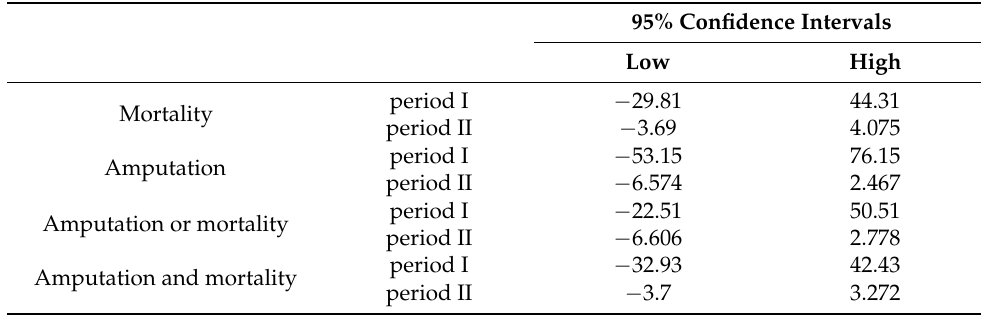
Figure 3. The hospitalized patients, the rates of ( A ) mortality, ( B ) amputation, ( C ) mortality or amputation, and ( D ) mortality and amputation per year before (blue lines) and after (red lines) the deployment of the HCAAS in January 2006. The trend lines established by linear regression before and after deployment of HCAAS are depicted as dotted and solid lines, respectively. Table 2. A 95% confidence interval for the rates of mortality, amputation, mortality or amputation, and mortality and amputation between periods I and